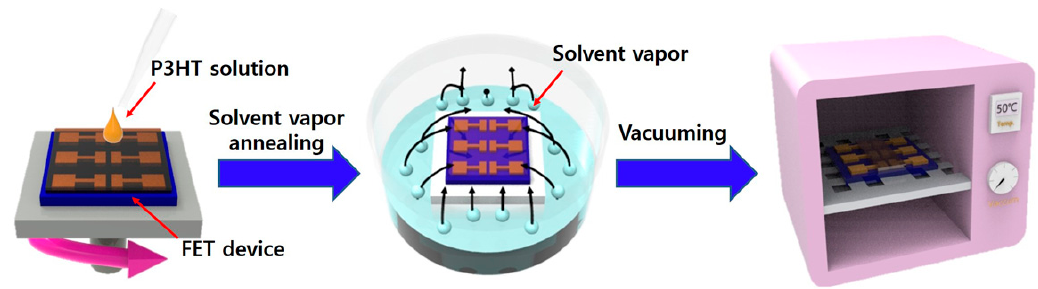
Figure 1. Schematic illustration of the procedure for solvent vapor annealing of poly(3- nanowire (P3HT-NW)-embedded P3HT thin films spin-coated on a field-e ff ect transistor hexylthiophene)-nanowire (P3HT-NW)-embedded P3HT thin films spin-coated on a field-effect